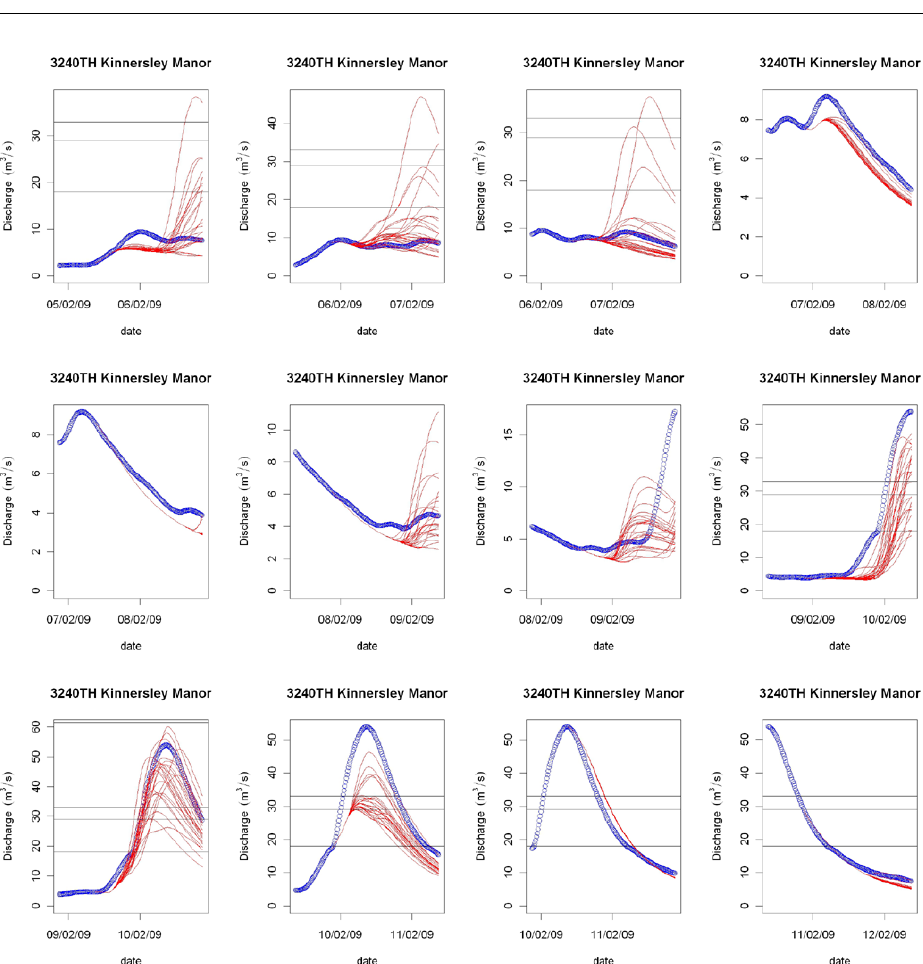
Fig. 5. Flow forecast ensembles for 12 consecutive forecasts, 12h apart, in February 2009 at Kinnersley Manor. Observed flows indicated by circles. Horizontal lines represent the thresholds from Table